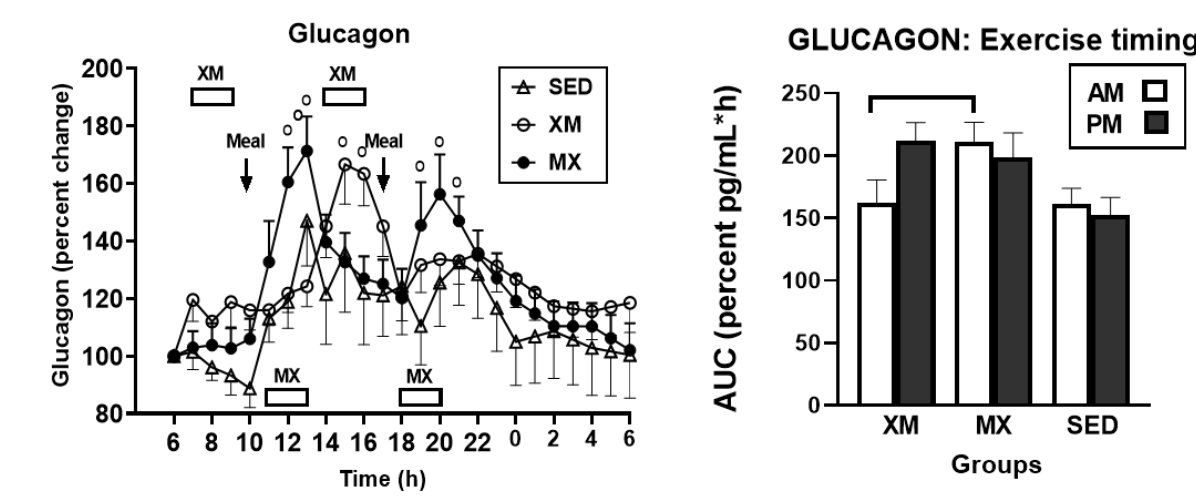
Figure 8. Exercise- and meal-timing effects on glucagon concentrations and its AUCs. Circles identify time slices when group differences were significantly different ( left panel). Bracket ( right panel) identifies a significant AUC difference between morning MX AUC being higher than morning XM AUC. EX = exercise, XM = exercise before meals, MX = exercise after meals, SED = sedentary group.